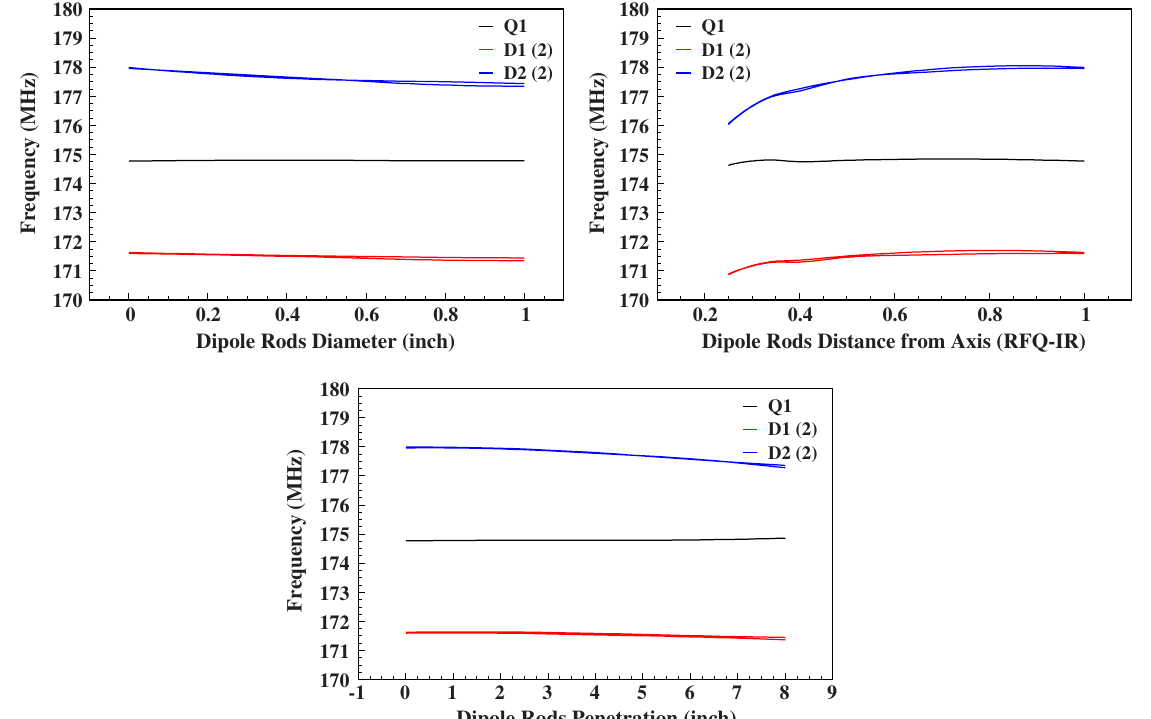
FIG. 6. Effect of dipole rods geometry parameters on mode separation. Q is for a quadrupole mode, D is for a dipole mode and (2) refers to a degenerate mode.